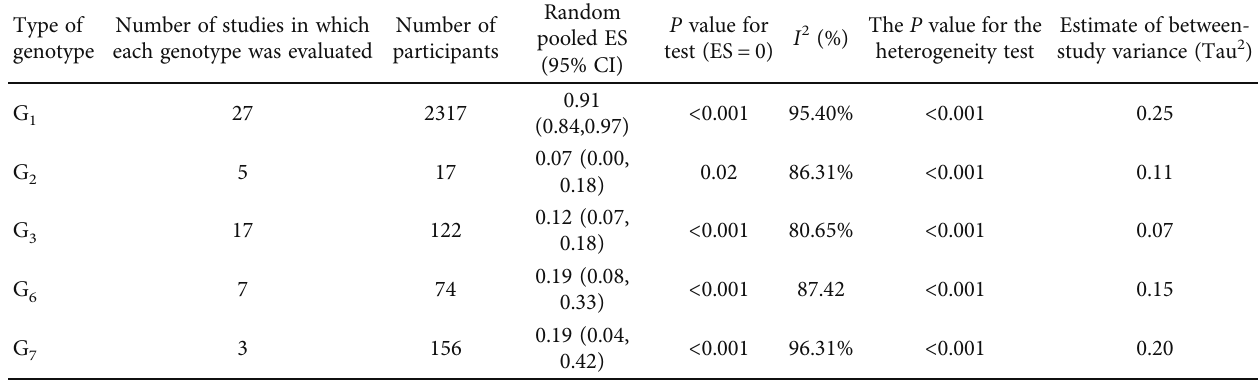
Table 3: The pooled estimate of cystic echinococcosis genotypes prevalence in animals of Iran. Type of genotype